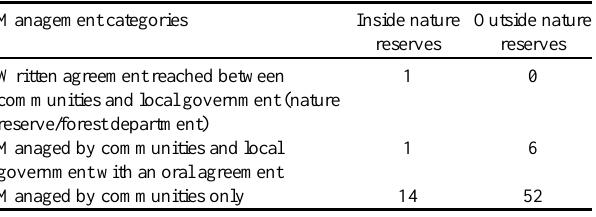
Table 2. Spatial relationship between monasteries (n = 74) and nature reserves (n = 17) and management categories of sacred mountains in Ganzi Prefecture, Sichuan Province,